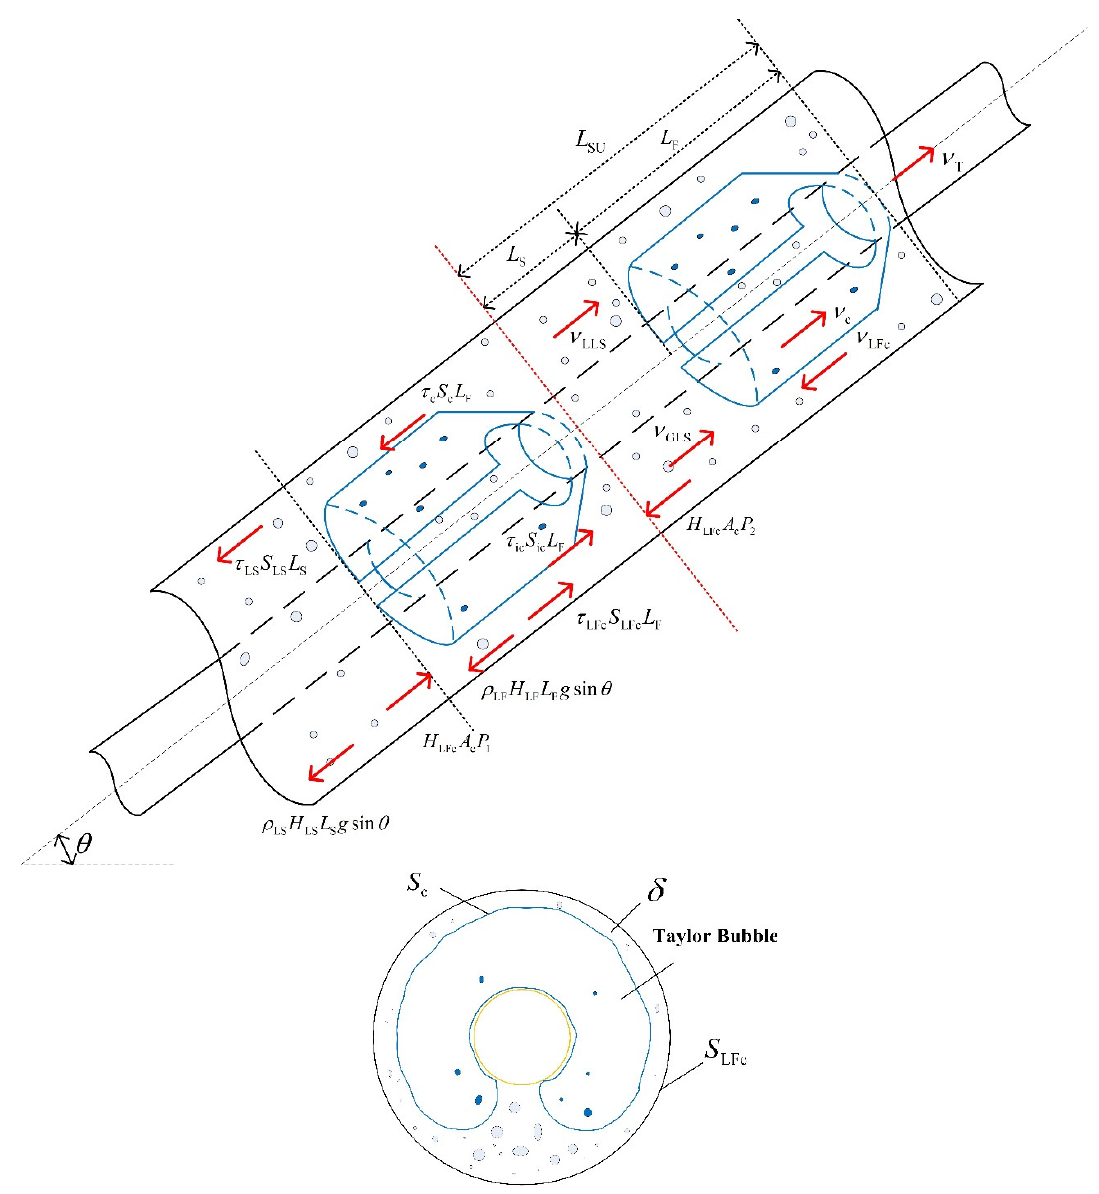
Figure 10. Schematic diagram of slug flow velocity and force analysis in the annular section.